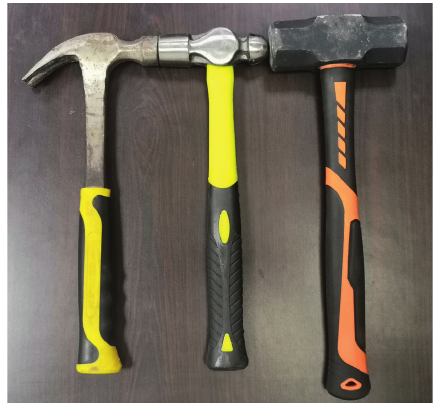
Figure 7: Hammers used in the